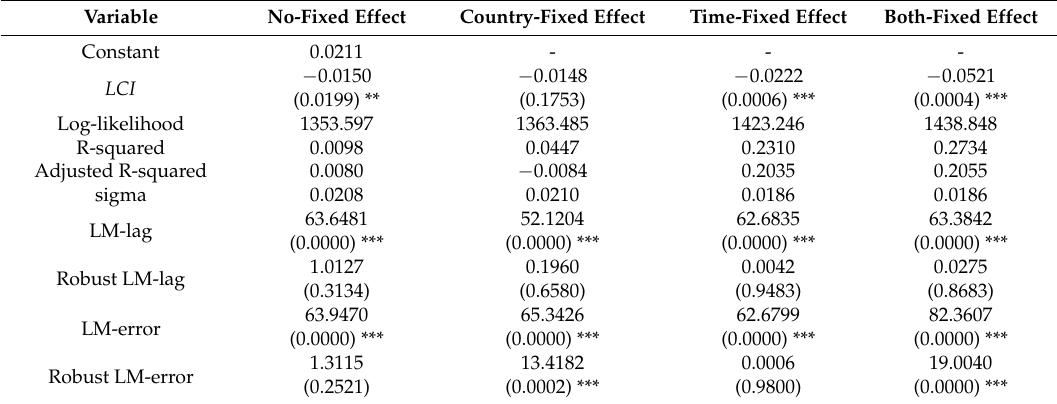
Table 6. OLS estimation and test results of absolute convergence of carbon intensity ( p -values in